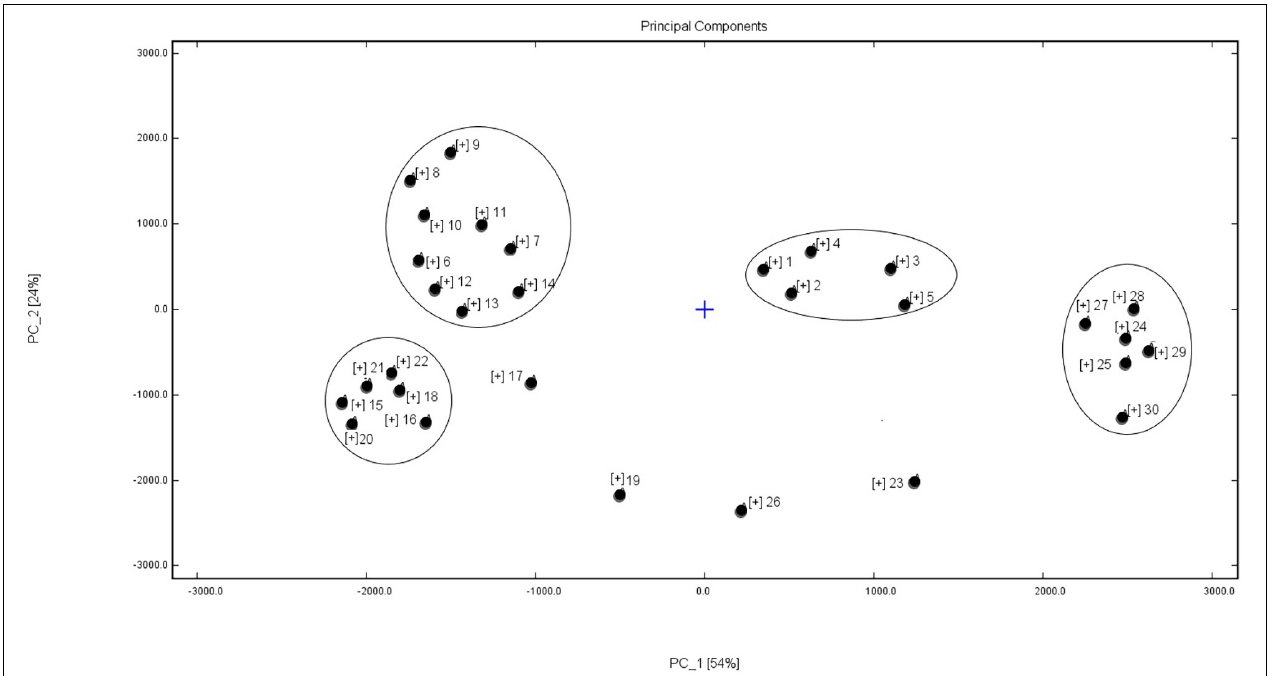
FIGURE 4 | Principal component analysis (PCA) results for volatile flavor compounds from vegetable soybean seeds from 30 different cultivars. The numbers, 1–30, indicate the 30 soybean cultivars shown in Table 1